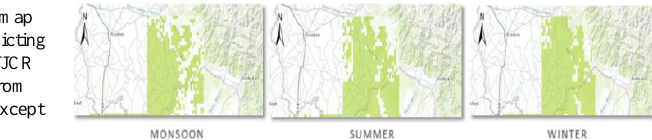
Figure 11 – Habitat Suitability Maps –